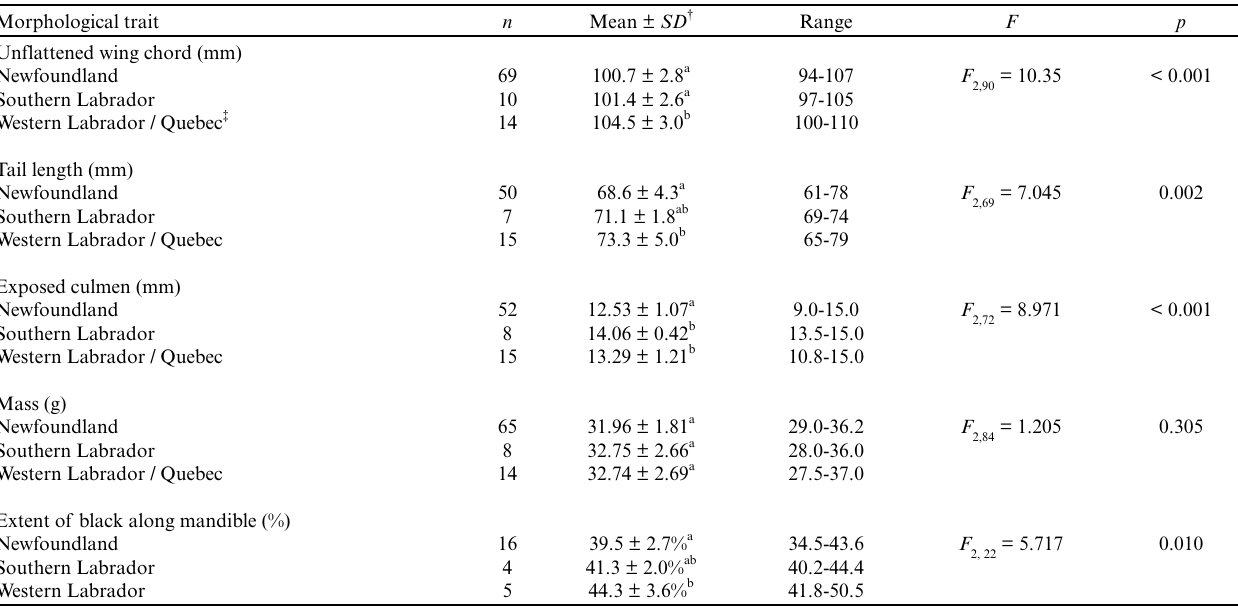
Table 2 . Morphological traits of male Gray-cheeked Thrushes ( Catharus minimus ) captured during the breeding season. Analysis of variance was used to test whether each trait differed across regions, while Tukey’s Honestly Significant Difference method was used to compare pairs of